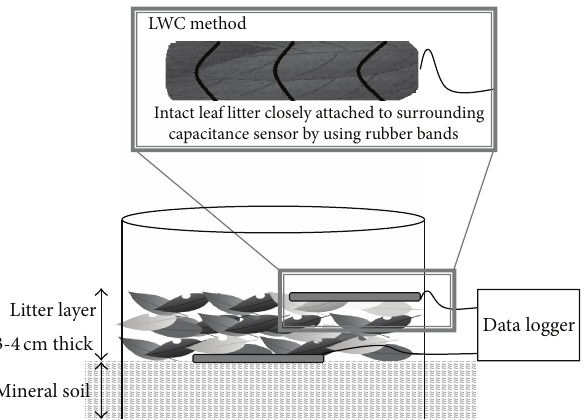
Figure 1: Design and installation of sensors used in the LWC